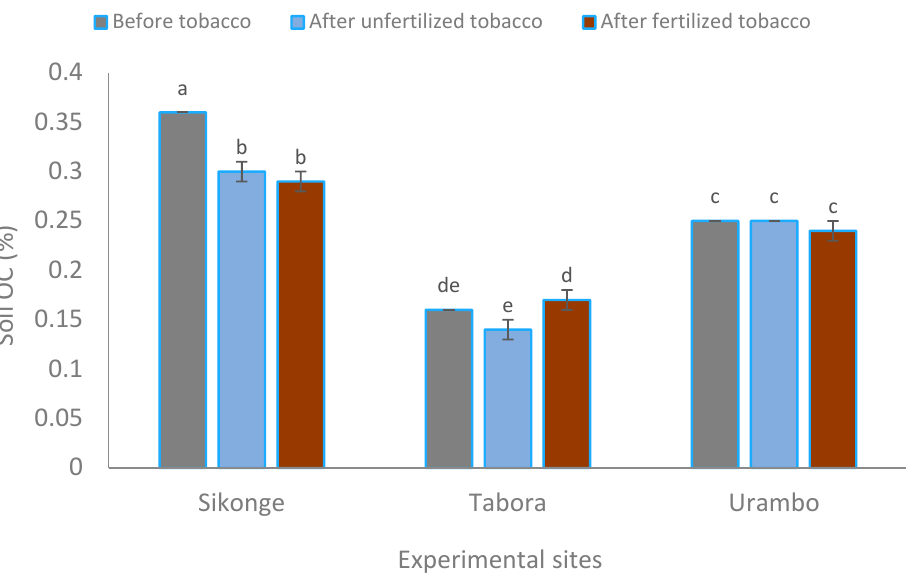
Figure 1. E ff ect of tobacco cultivation and fertilizer supply on soil pH. ‘a’ is very highly significant; ‘ab’ is very significant; ‘b’ is significant and ‘c’ non significant.